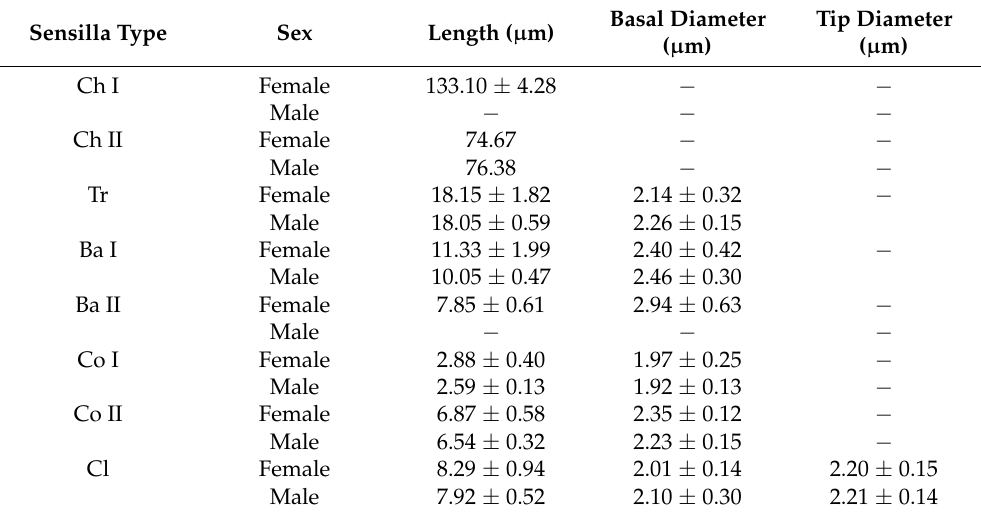
Table 1. Morphometric data of antennal sensilla in Gyrostigma rhinocerontis (mean ± SD, n = 15, n = 1 for Ch